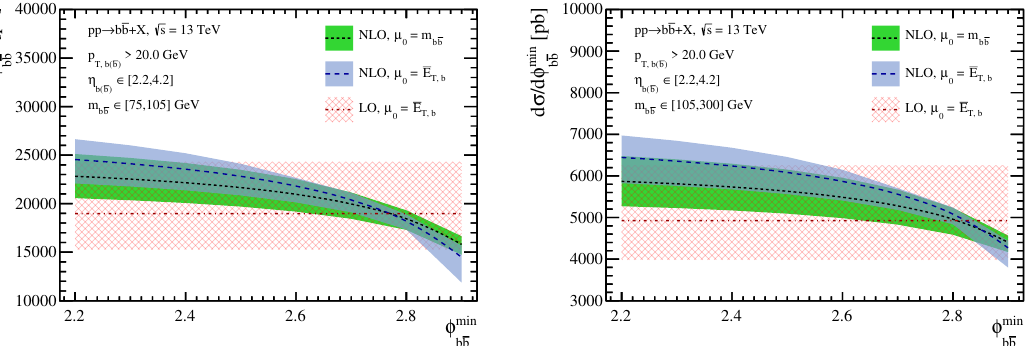
Figure 4 . Dependence of the b (cid:22) b cross section on the minimum angular separation (cid:30) min